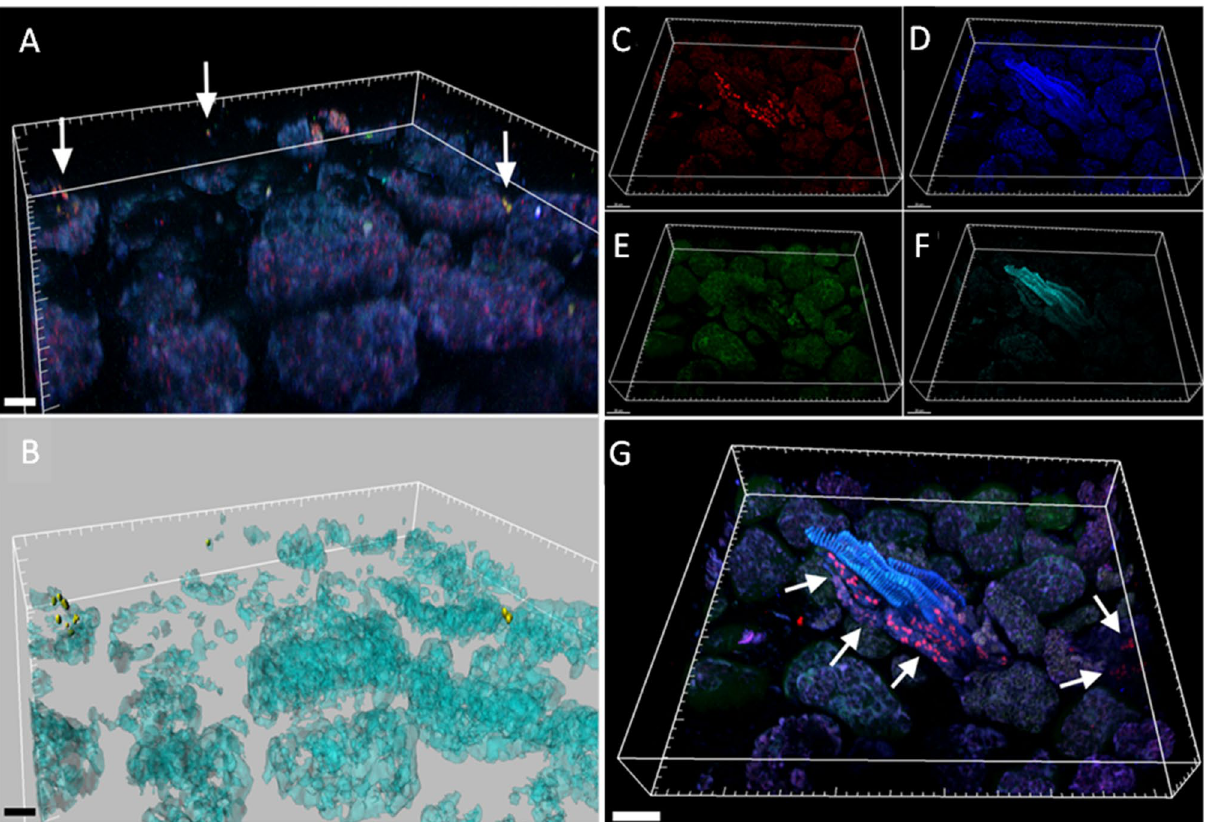
Figure 5. Bacterial colonization of C. limon shoots regenerated in aseptic condition from surface-sterilized seeds. Confocal laser scanning microscopy images showing the bacterial colonization of Citrus limon (L.) Burm. F. in vascular bundles and parenchyma of shoots germinated by surface-sterilized seeds. Cryosections were stained by Fluorescent In Situ Hybridization. ( A ) Volume renderings showing Firmicutes bacteria (signal of the Firmicutes -specific probe LGC354MIX, arrows). ( B ) Three-dimensional model of panel ( A ). ( C ) Volume renderings showing unidentified bacteria inside the vascular bundles (signal of the EUB338MIX universal probe, arrows). ( D – F ), Volume renderings showing shoot tissue auto-fluorescence; ( G ) overlap of panels ( C – F ). Scale bars = 20